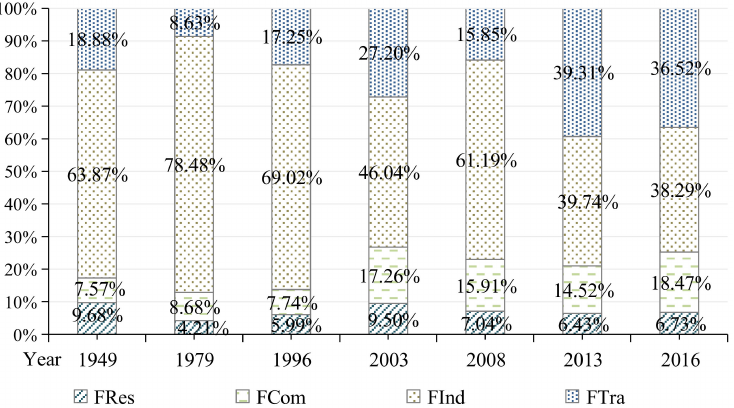
Figure 7. The structure of carbon emissions by sector from 1949 to 2016.